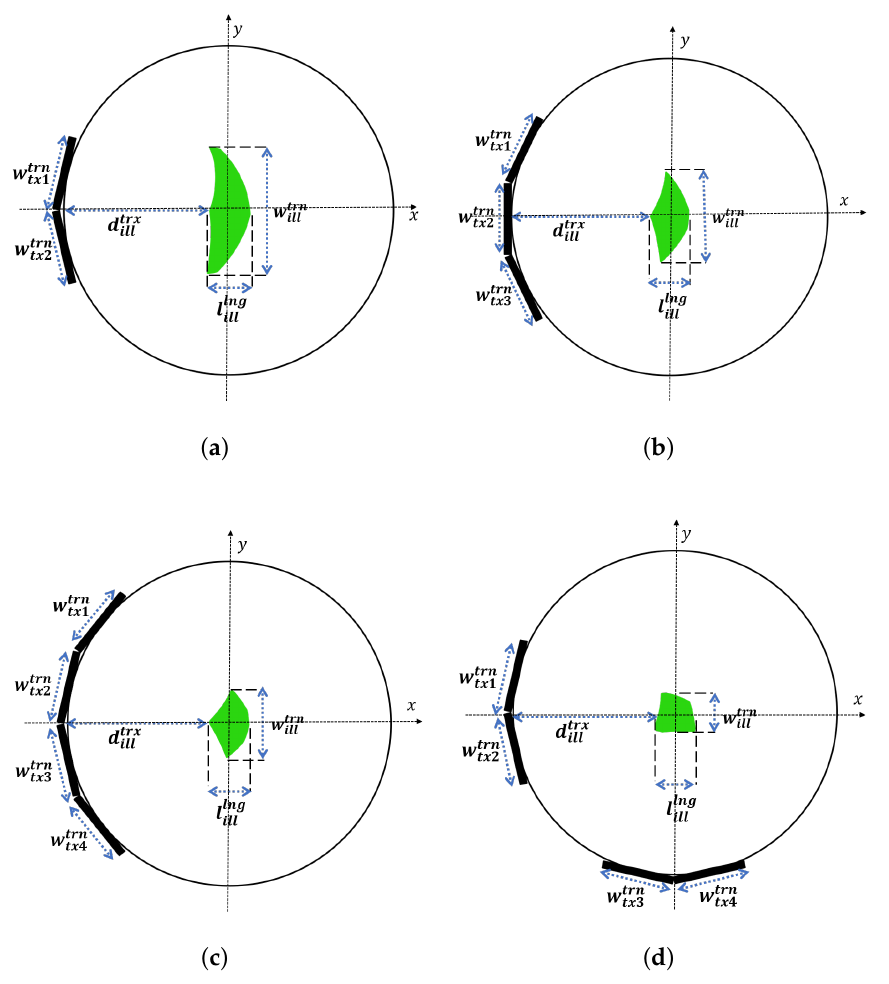
Figure 3. Geometric analysis of image resolution. ( a ) Two UWB antennas. ( b ) Three UWB antennas. ( c ) Four UWB antennas. ( d ) The orthogonal set of two